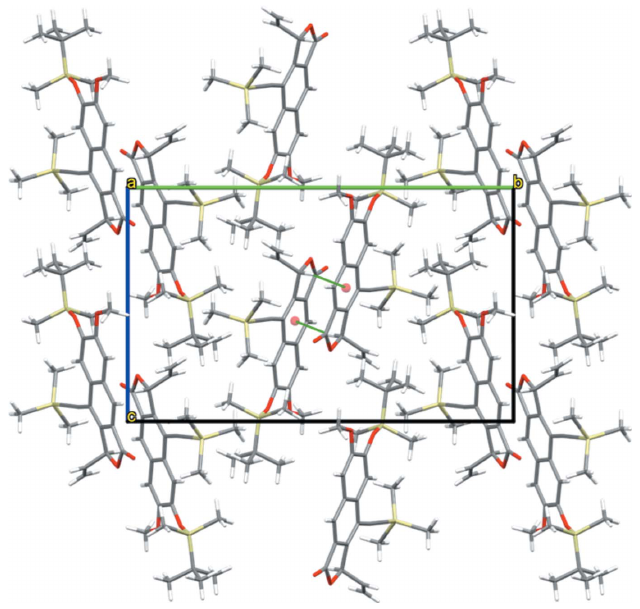
Figure 3 View of the crystal packing along [100]. Mutual C—H (cid:2)(cid:2)(cid:2) (cid:2) interactions (green lines) lead to the formation of inversion-related dimers, as emphasized in the middle of the unit cell. For clarity, only the disordered part with major contribution is shown.